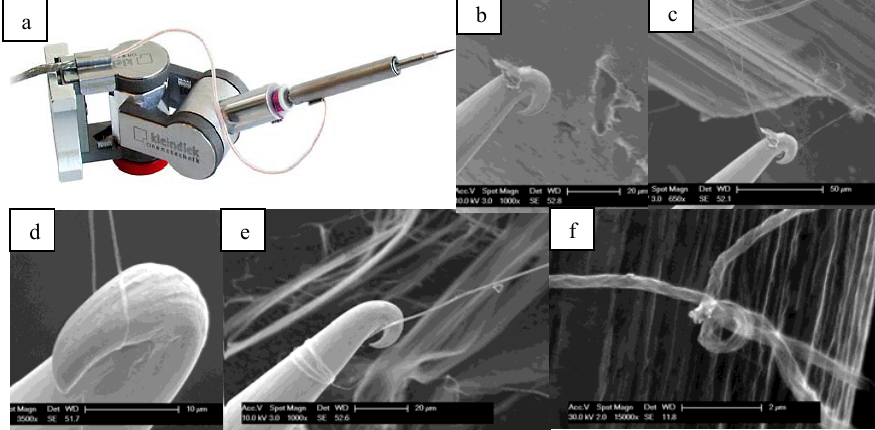
Figure 1. Spinning nanothread: ( a ) rotational tip used; ( b ) making a hook by pushing a probe against aluminum; ( c ) using the hook to pick up a very small bundle of Carbon Nanotubes (CNTs); ( d ) pulling and rotating the hook; ( e ) CNT thread is wound on the hook; ( f ) CNT nanothread with 300 nm diameter; The thread is so thin it looks almost transparent under the SEM.